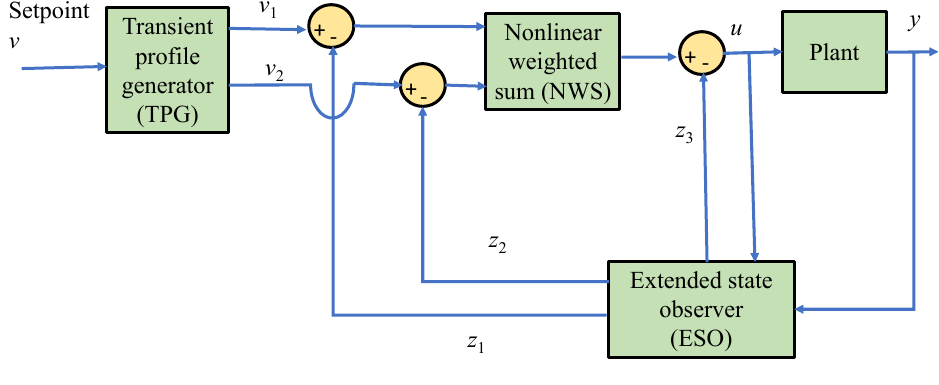
Figure 1. Structure of ADRC.